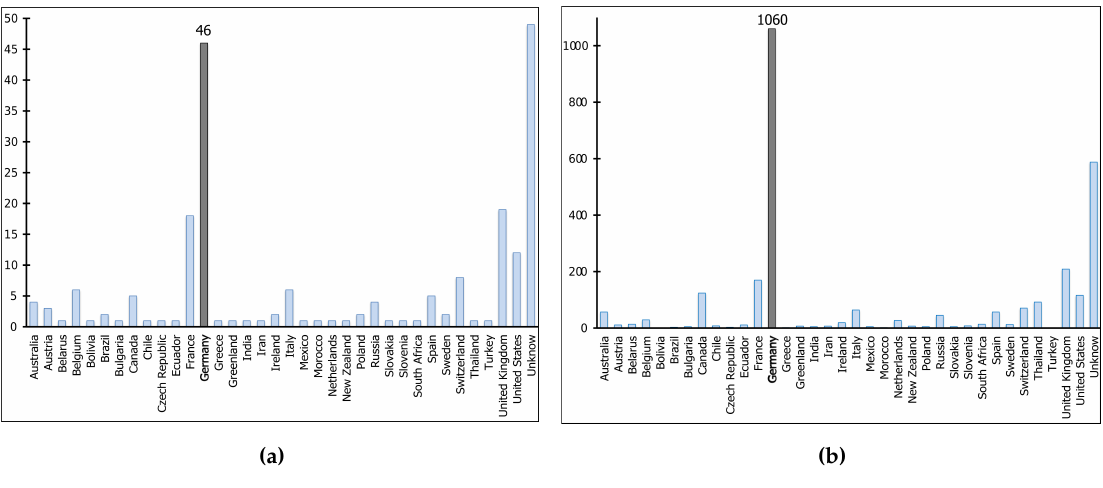
Figure 8. Participant and contribution patterns with respect to the participant geographic origins. ( a ) The distribution of participant geo-origins, ( b ) Contributions relative to participant geo-origins.